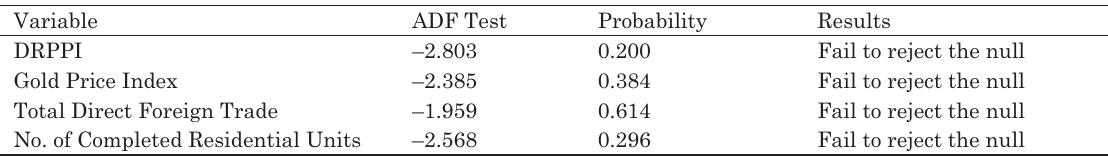
table 2. summary of aDf tests for unit roots in the variables (in level from with a trend and intercept) Variable